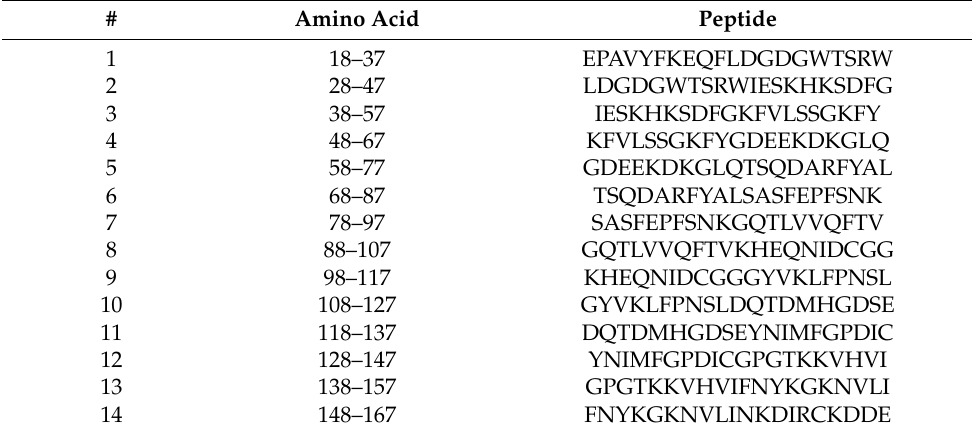
Table A1. Overlapping CRT Peptides Covering the CRT